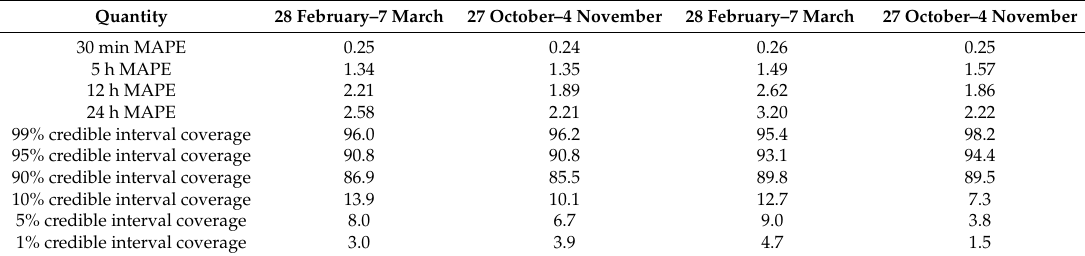
Table 6. Results for the GPoE and uncombined models. The first two data columns correspond to the error GPoE model, and the second two correspond to the single best model for each forecast. The credible interval coverage is a Monte Carlo approximation to the true coverage. It represents the percentage of data points in the test period that fall below the corresponding credible interval using 1000 samples from the posterior